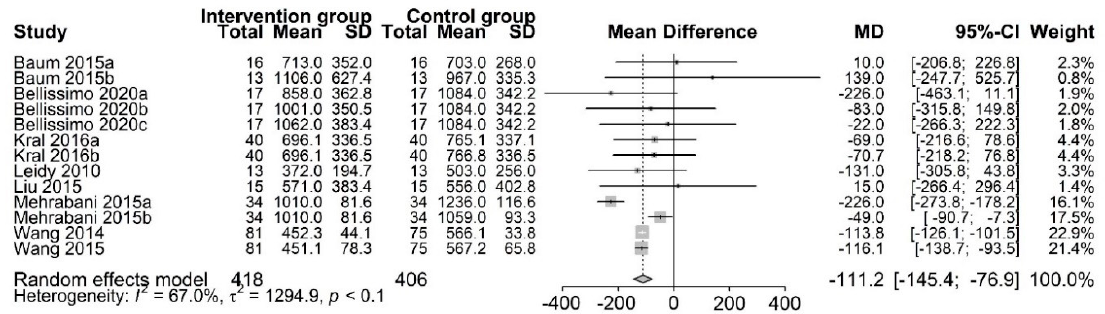
Figure 4. Random–effects meta–analysis of relationships between protein–rich breakfast and subsequent energy intake (kcal). Data for Baum 2015a [13] are based on non–overweight participants, whereas data for Baum 2015b [13] are based on overweight participants. Bellissimo 2020a [20], Bellissimo 2020b [20], and Bellissimo 2020c [20] are based on different subsets of subjects who identified as different dose protein breakfast consumers. Kral 2016a (Oatmeal vs. Scrambled eggs) [15], Kral 2016b (Cereal vs. Scrambled eggs) [15], Mehrabani 2015a (LFM vs. W) [23], and Mehrabani 2015b (LFM vs. AJ) [23] are based on different subsets of subjects who identified as different control groups, respectively. Other studies were defined as Leidy 2010 [16], Liu2015 [14], Wang2014 [17], and Wang 2015 [24], respectively.